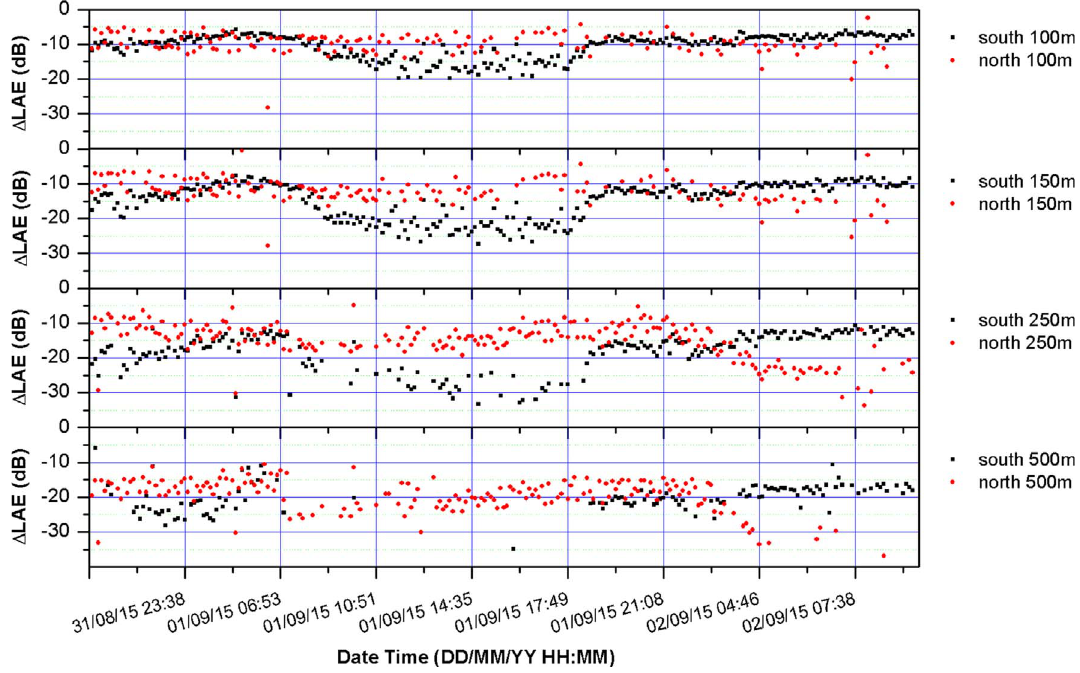
Figure 5. Aderklaa: Comparison of the sound exposure level difference ( D L A,E ) at different distances north and south of the railway